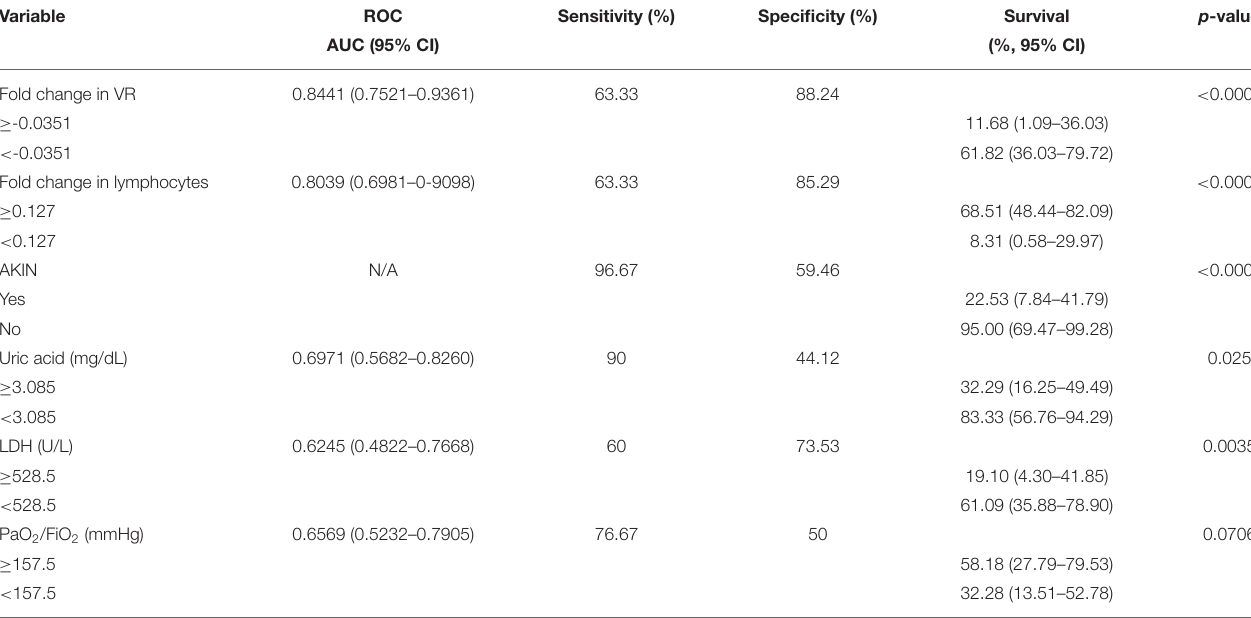
TABLE 5 | Survival rates of severely ill COVID-19 patients according to their clinical characteristics. Variable ROC Sensitivity